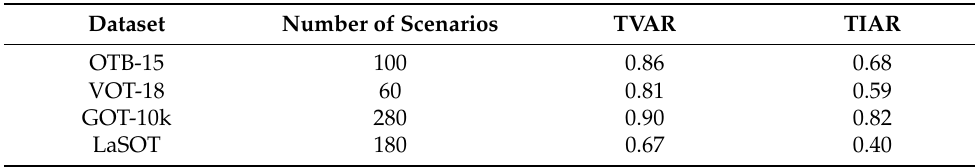
Table 3. TIAR of the Arbiter model on several datasets.